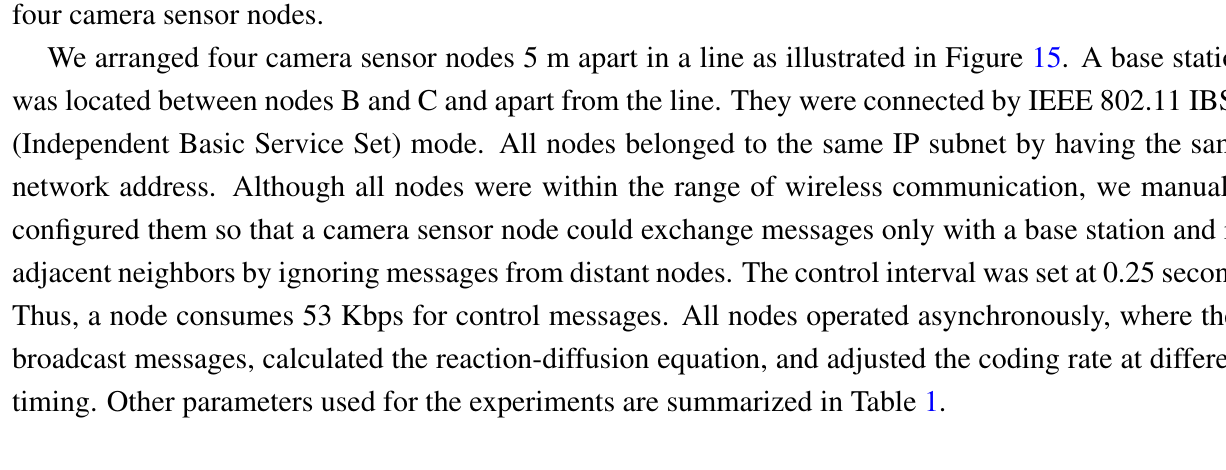
Figure 15 . Node layout in experimental